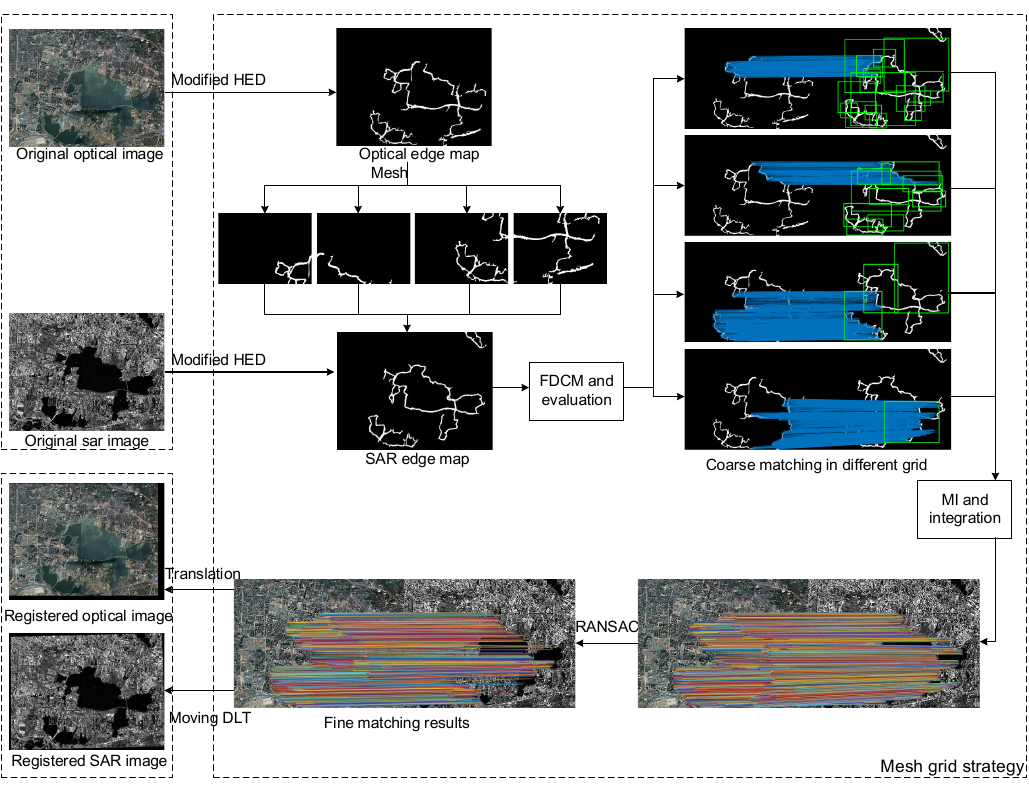
Figure 5. Framework of the proposed